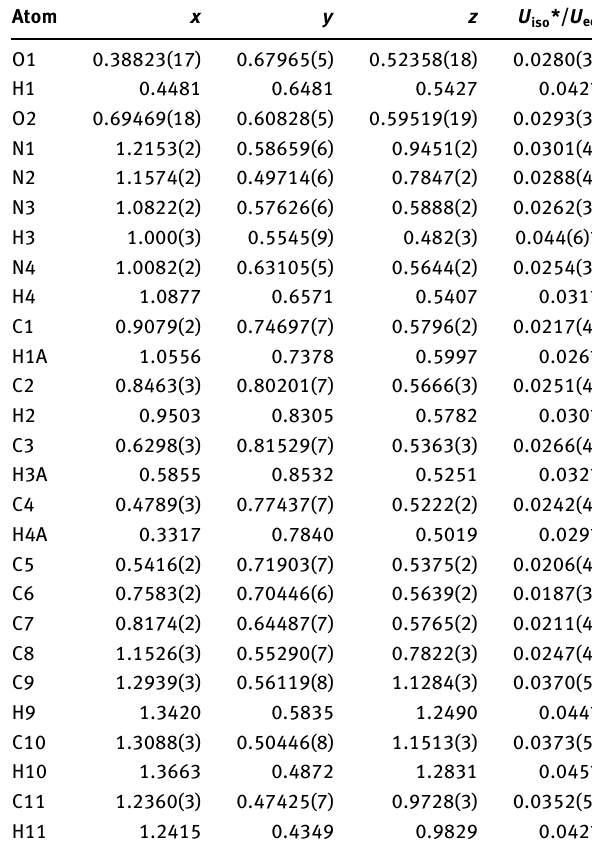
Table 2: Fractional atomic coordinates and isotropic or equivalent isotropic displacement parameters (Å 2